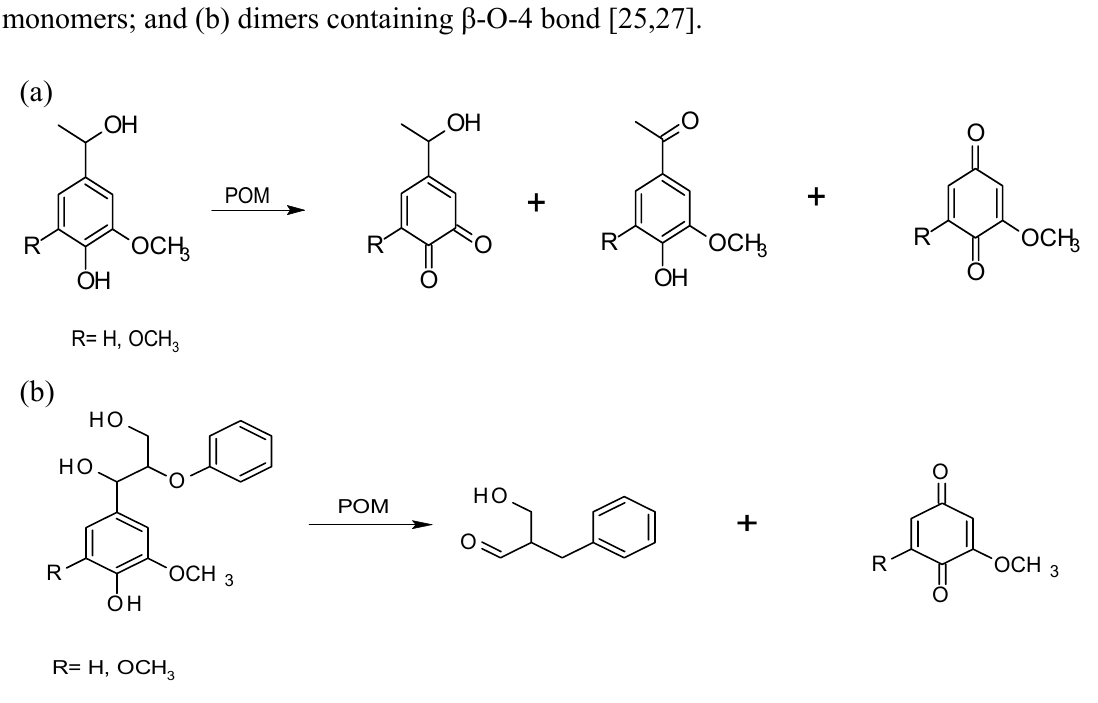
Figure 7. Quinonoid and aromatic products of POM treatment of phenolic LMCs: (a) monomers; and (b) dimers containing β -O-4 bond